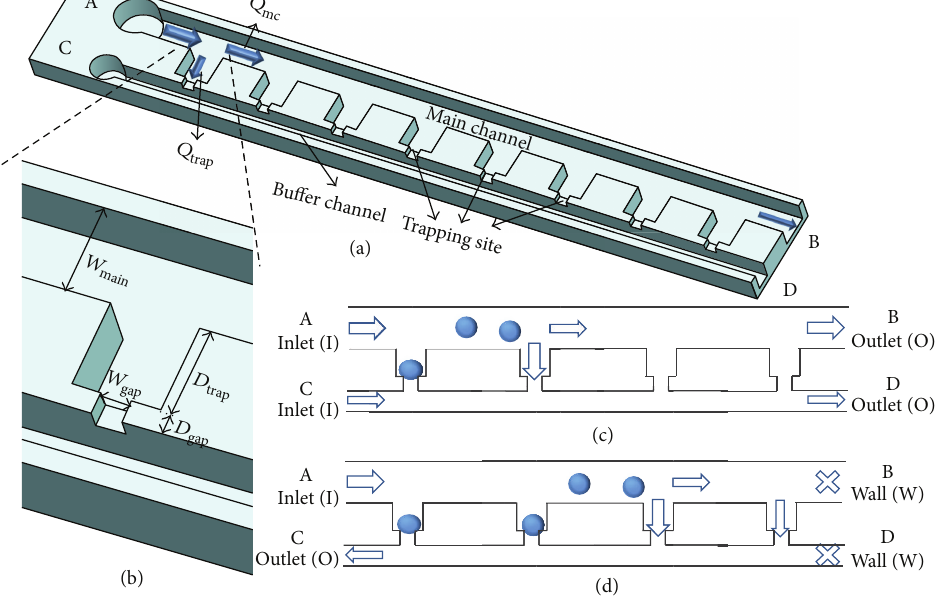
Figure 1: Principle of single-cell positioning based on the hydrodynamic trapping mechanism. (a) Schematic of the cell trapping structure, which consists of two parallel channels (main channel and buffer channel) connected with cellular trapping sites with a decrease in the cross-sectional area. A, B, C, and D represent the main channel inlet, main channel outlet, buffer channel inlet, and buffer channel outlet, respectively. Four critical geometry parameters of the trapping site 𝑊 outlet, there are three possible statuses, which are I (inlet with a defined fluid flow rate as boundary condition), O (outlet with zero pressure as boundary condition), and W (wall with zero fluid flow velocity as boundary condition). By regulating the status of channel inlets and outlets, this structure can represent previous designs where (c) represents the structure proposed by Shoji et al. [26] and (d) presents the structure put forward by Lu et al.